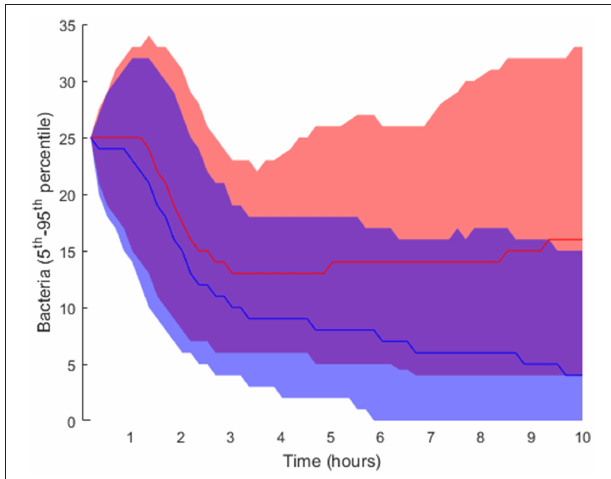
FIGURE 7 | Interpercentile range between the 5th and 95th percentiles for final bacteria numbers of the intracellular-level solutions for the high load group in red and low load (blue). The lines represent the median of each